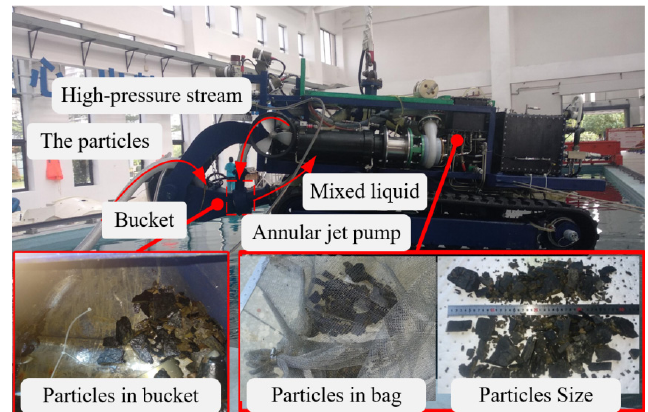
Figure 13. Collection function test method and results.